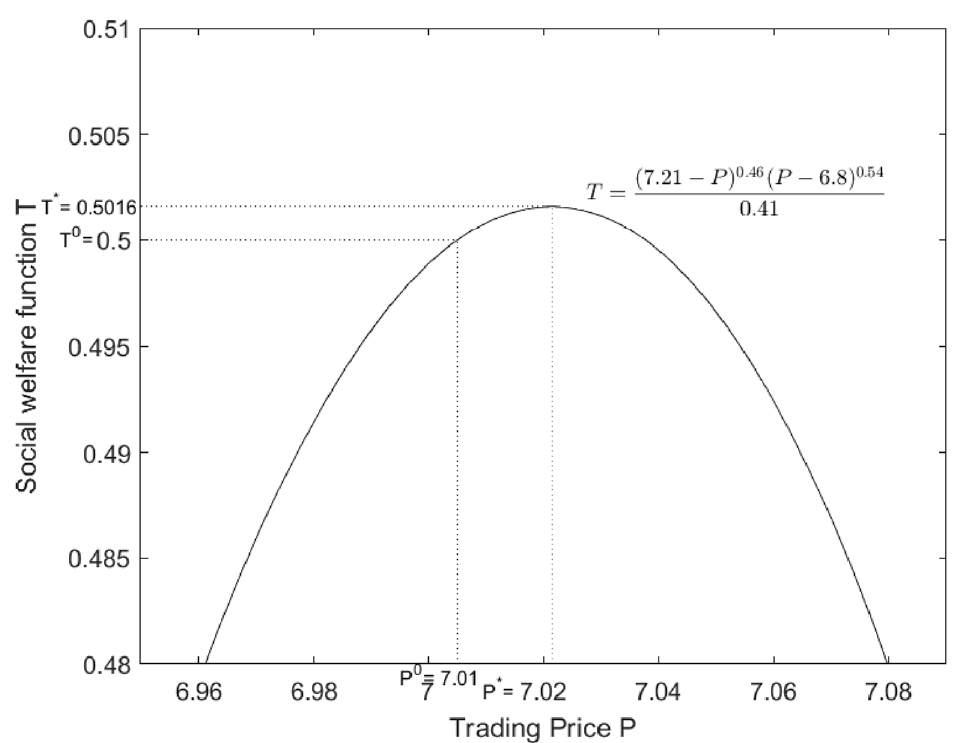
Figure 4. Schematic diagram of the optimal transaction price.